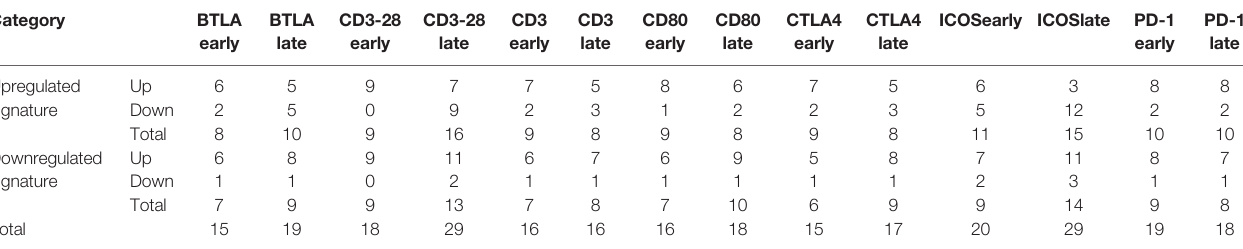
TABLE 9 | Treg signature genes from spleen and lymph nodes were stimulated by anti-CD3 and either anti-CD28, -CTLA4, -ICOS, -PD1, -BTLA, or -CD80 antibodies for a time course of 1, 4, 20, and 48 h (hr), respectively (GSE42276).